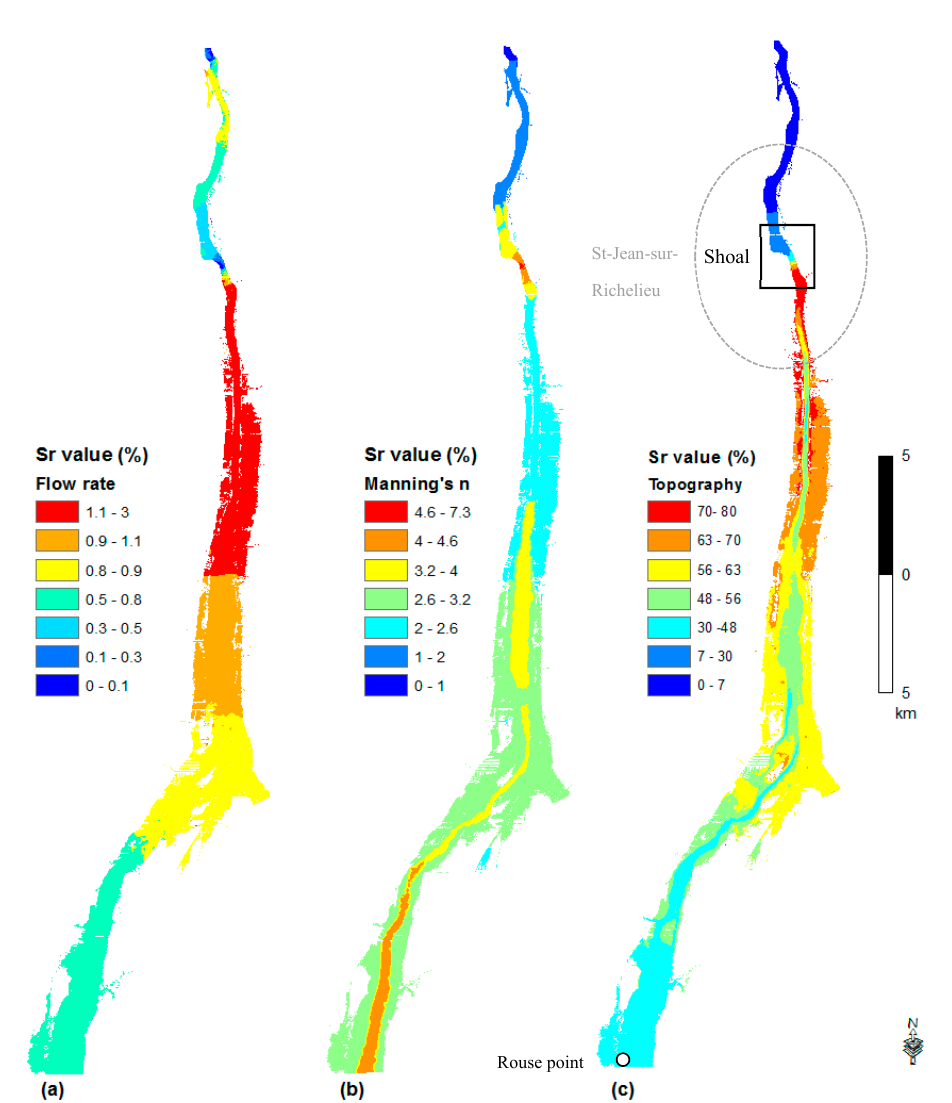
Figure 8. Sensitivity of the simulated flow depths for each of the three input variables, ( a ) flow rate Sr ( X 1 ) , ( b ) Manning’s n coe ffi cient Sr ( X 2 ) , and ( c ) topography Sr ( X 3 ) , for nominal flow rate of 1113 m 3